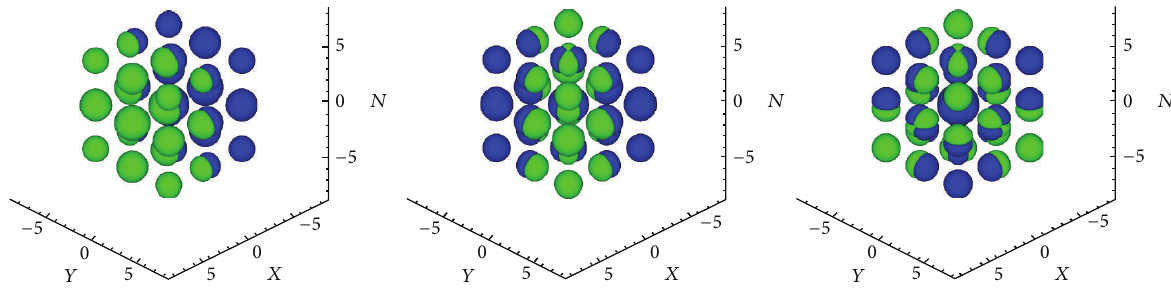
Figure 5: The isosurface plots of first excited state in Example 3 with |𝜙 100 | = 0 . 01, |𝜙 110 | = 0 . 01, and |𝜙 111 | = 0 .